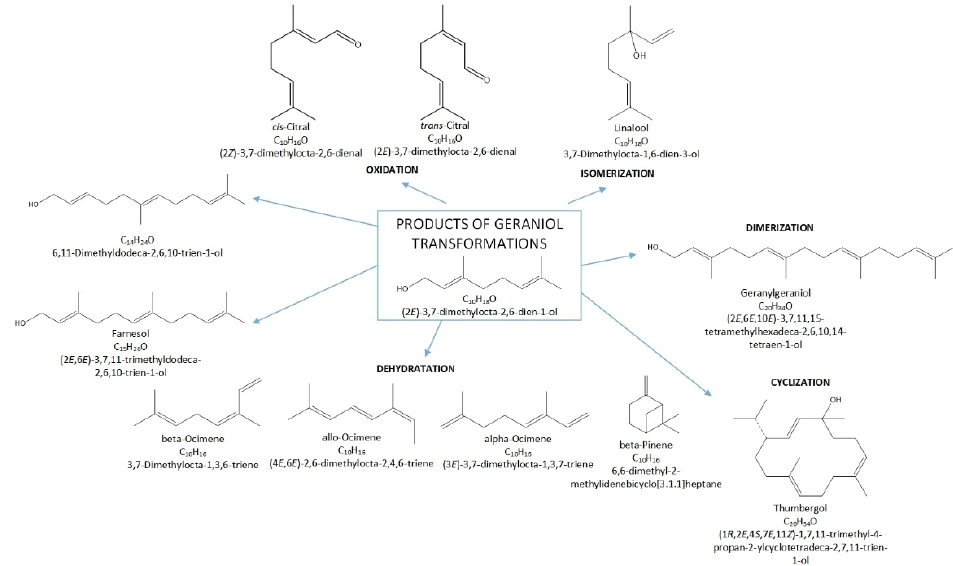
Figure 2. Diagram of the main chemical reactions taking place during the transformations of GA.